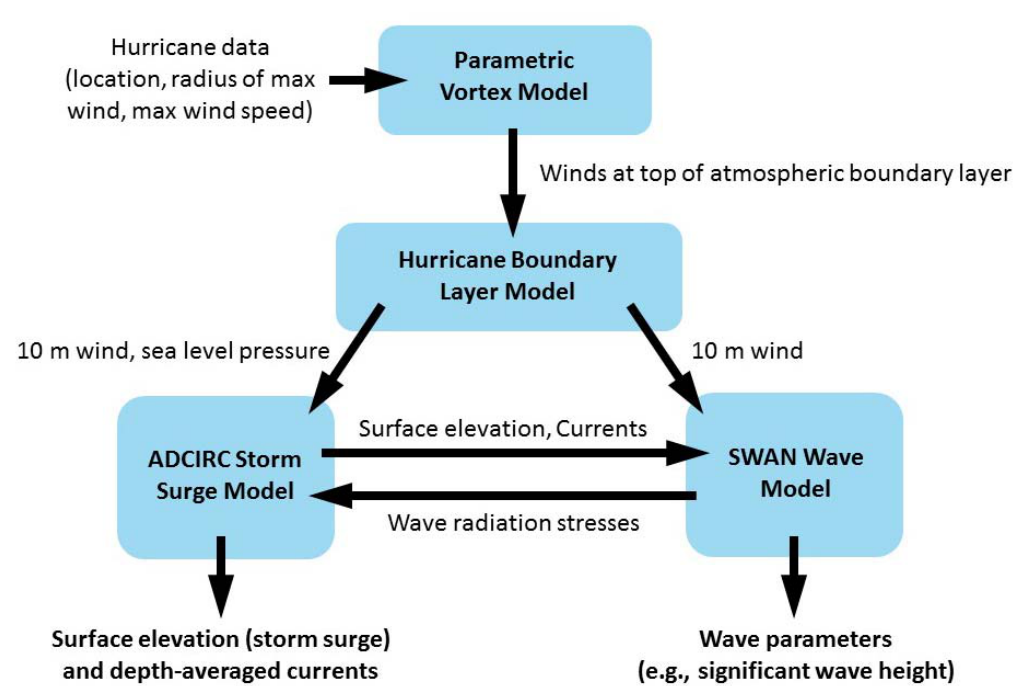
Figure 4. Overview of the hurricane modeling system. Additional modules (e.g., river flooding) may be integrated into this structure. Image: Authors.